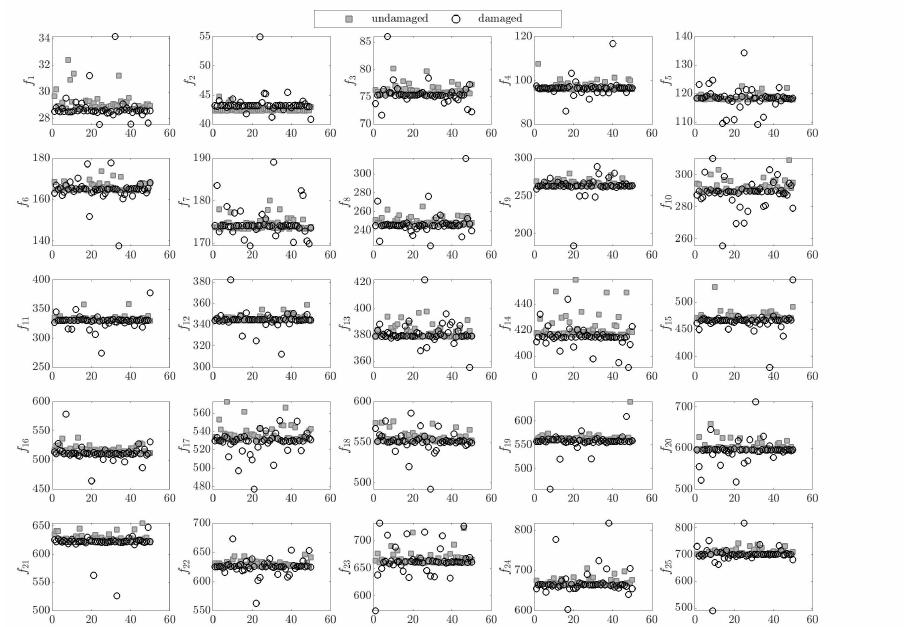
Figure 4. The first 25 eigenfrequencies, [Hz], for damaged and undamaged samples are slightly different and not linearly separable (horizontal axis: no. of